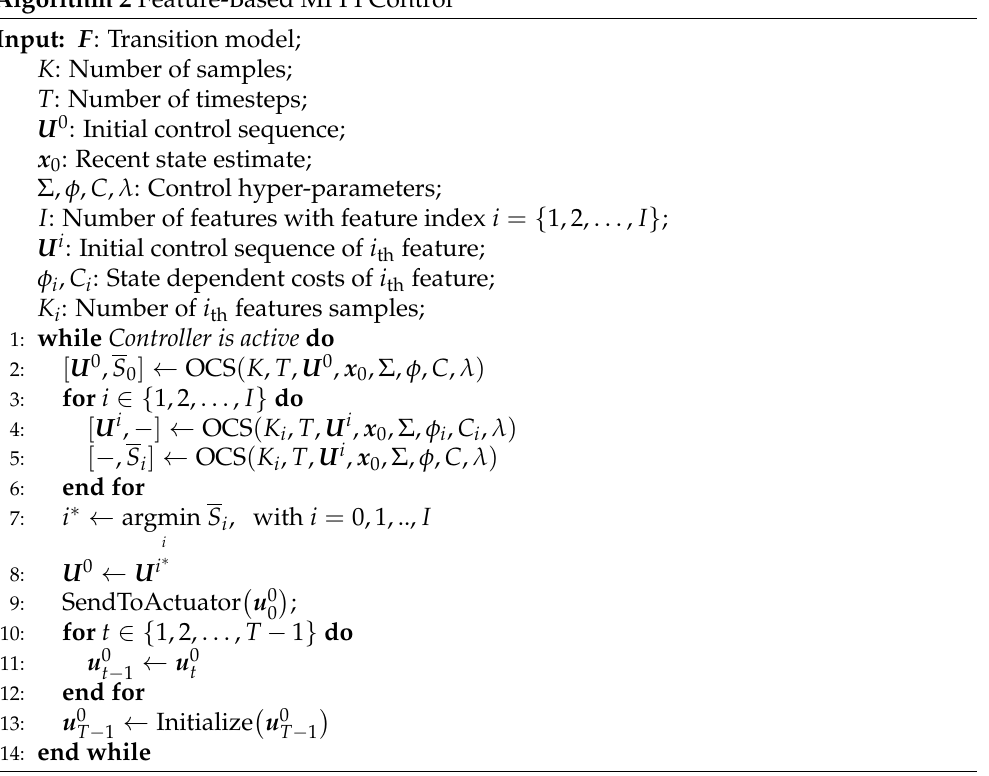
Algorithm 2 Feature-Based MPPI